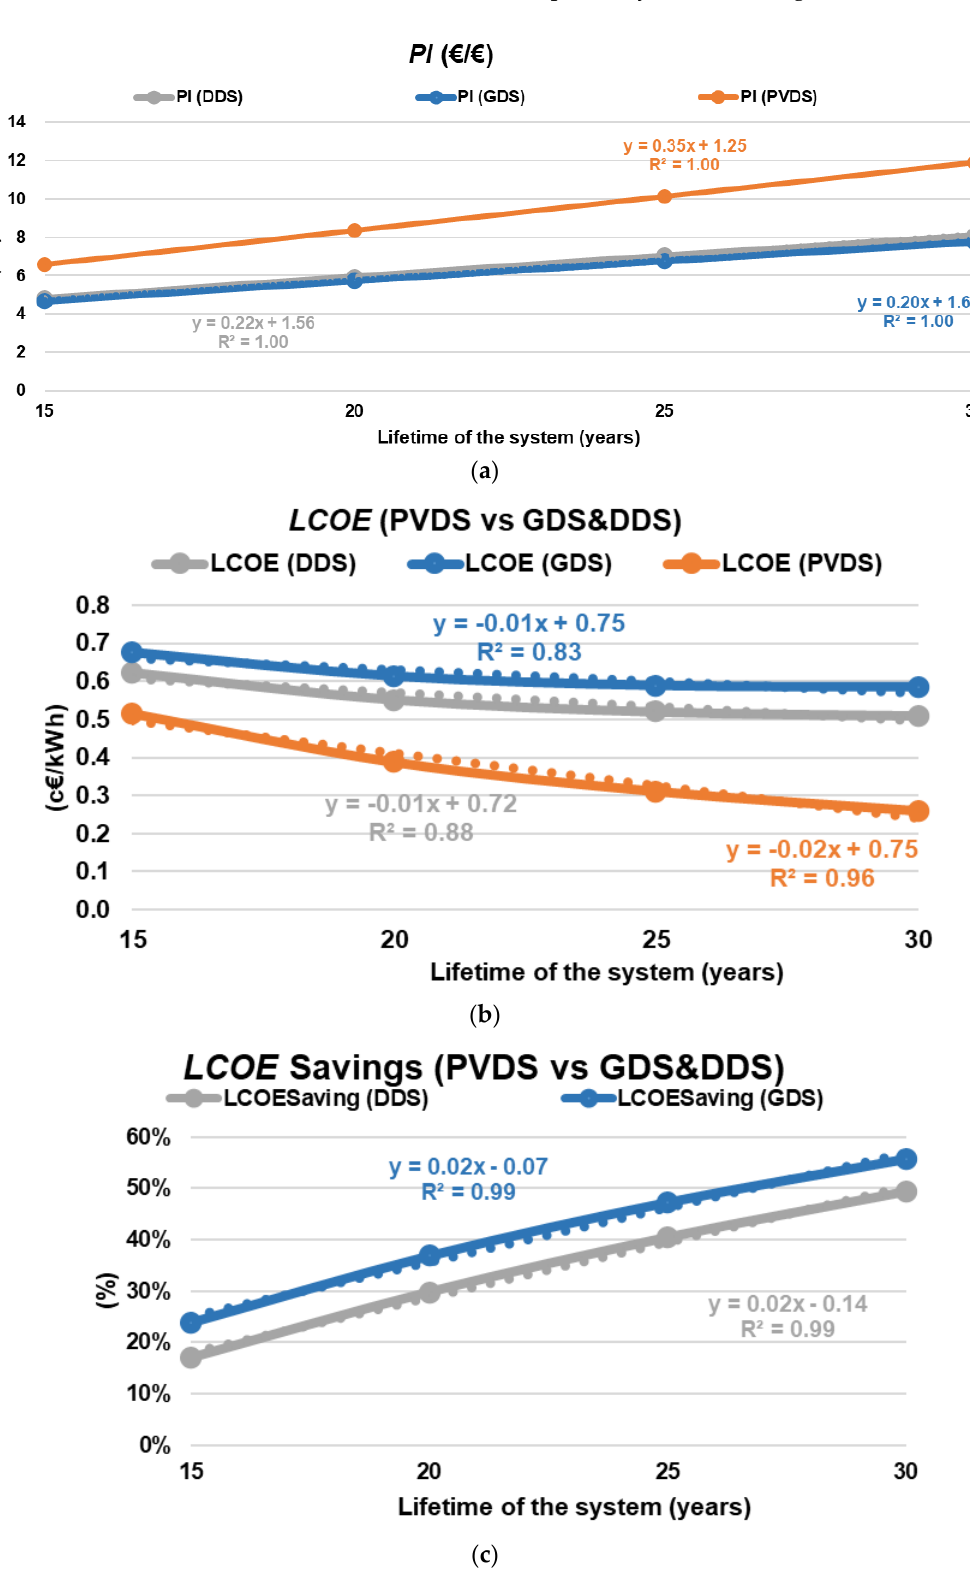
Figure 6. Profitability index ( a ), levelized cost of energy ( b ), and LCOE savings ( c ) obtained for a lifetime of the system between 15 and 30 years for the cases PVDS vs. DDS and PVDS vs. GDS.